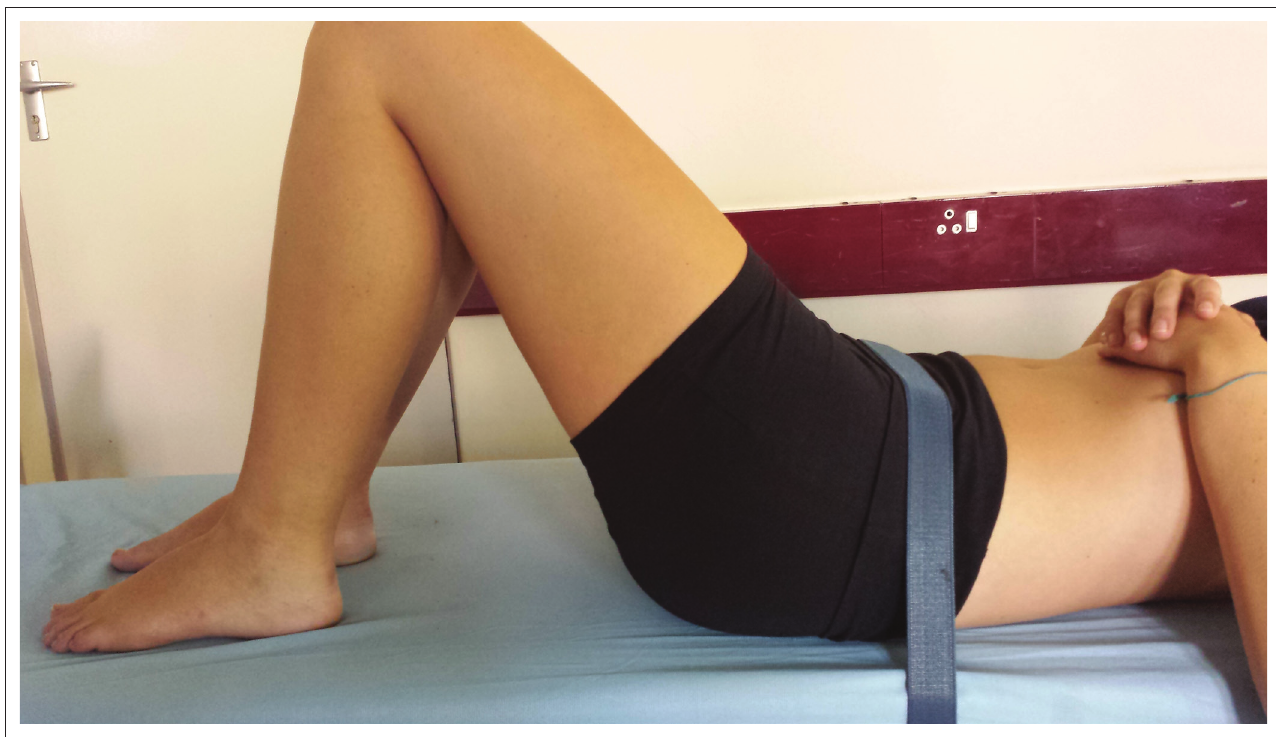
FIGURE 1: Photograph of the crook-lying position with Velcro